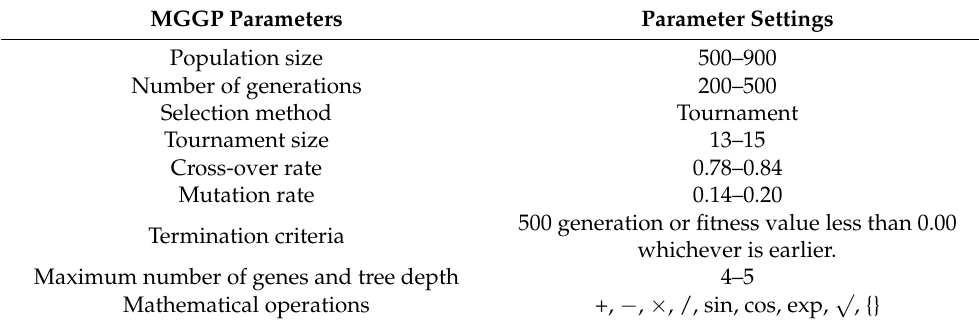
Table 2. Parameter setting for